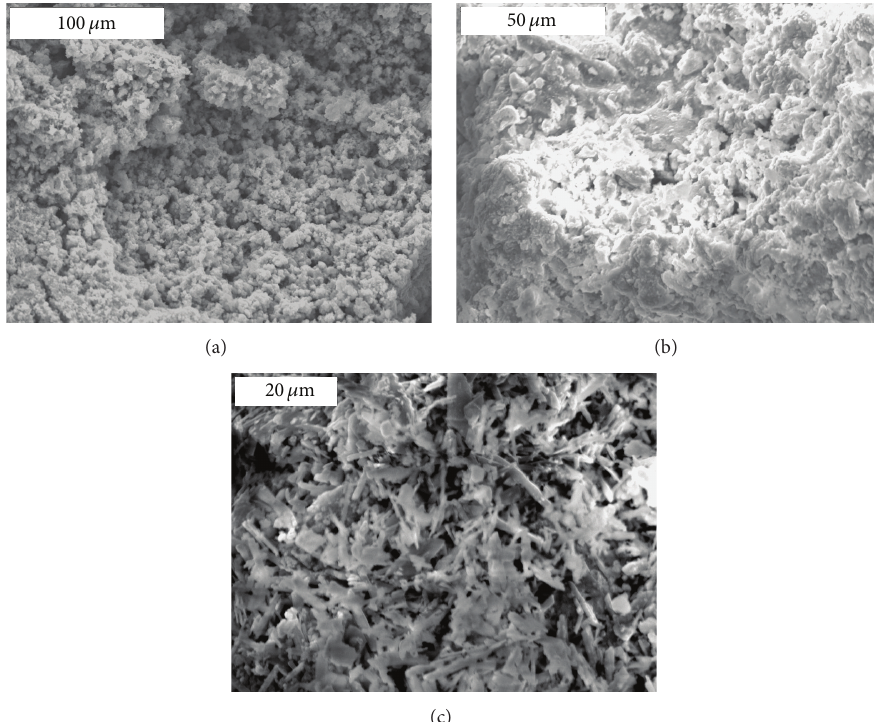
Figure 2: SEM microphotographs of (a) waste filter sand, (b) blast furnace slag, and (c) modified blast furnace slag.